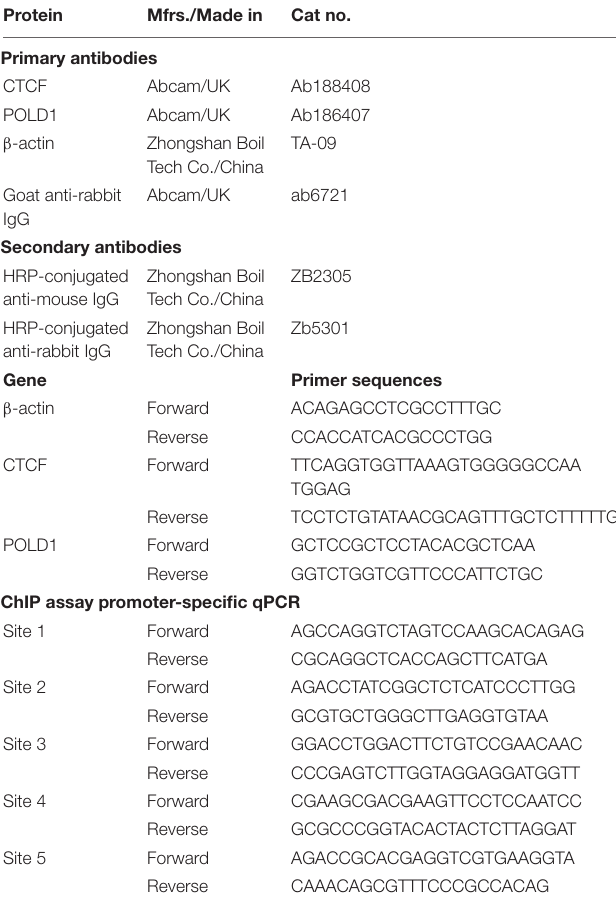
TABLE 2 | Antibodies and sequences used for Western blotting and